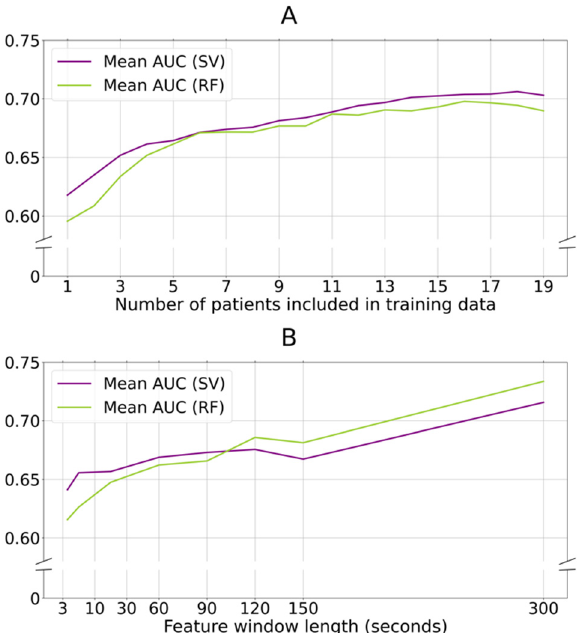
Figure 4. Increasing number of training patients and length of data window duration improves classification performance. ( A ): Group models are trained for every patient with a varying number of included training data, ( x -axis). On the y -axis, the AUC is shown for both SV and RF models (both included activity filtering). An increase in AUC is seen for SV and RF models parallel to an increase in included training patients. ( B ): Group models are trained for every patient with various feature window lengths ( x -axis). On the y -axis, the AUC of the SV and RF models are visualized. Due to the longer feature window lengths, the activity filter in this sub-analysis is not applied to data size limitations. Larger window lengths up to 300 s increase classification performance, while smaller window lengths decrease classification performance. AUC: area under the receiver operator characteristic; SV: support vector classifier; RF: random forest classifier.